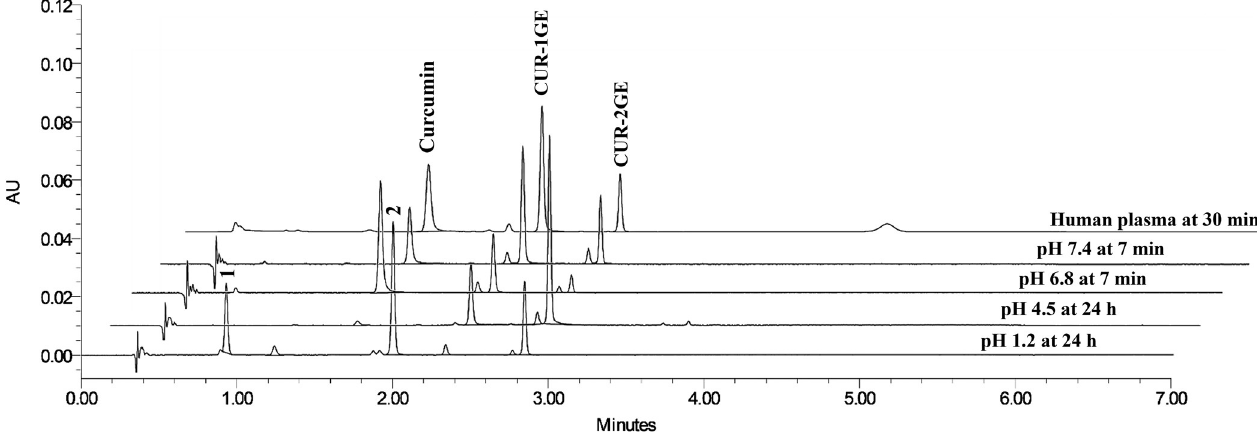
Fig 2. Representative chromatograms of CUR-2GE incubated at 37˚C in buffers at pH 1.2, 4.5, pH 6.8, pH 7.4, and human plasma for 24 h, 24 h, 7 min, 7 min, and 30 min, respectively. The retention times of curcumin, CUR-1GE and CUR-2GE were 1.6, 2.3 and 2.8 min, respectively, and the retention times of major unknown compounds 1 and 2 were 0.9 and 2.0 min,